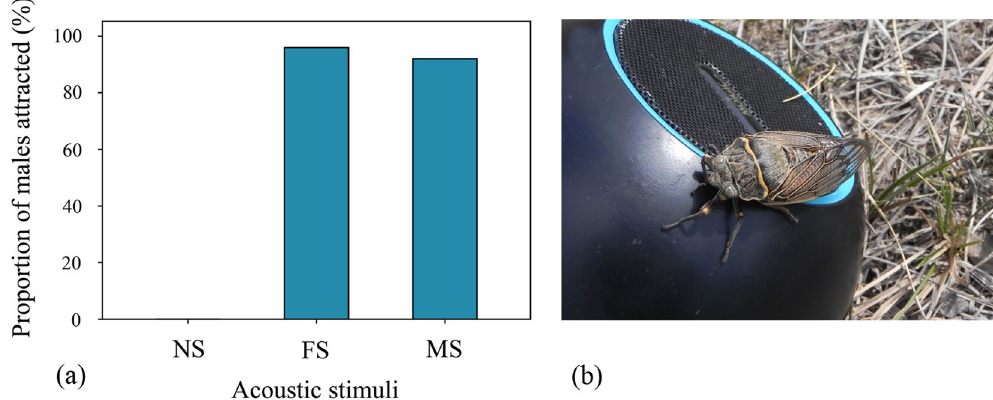
Figure 4. Acoustic playback experiments. ( a ) The efficiency of the playback stimuli in eliciting phonotactic responses from male cicadas. FS: the sounds produced by S . yangi females; MS: the sounds produced by an observer’s mouth; NS: no sounds. ( b ) A male was attracted by playback of MS and landed on the loudspeaker.